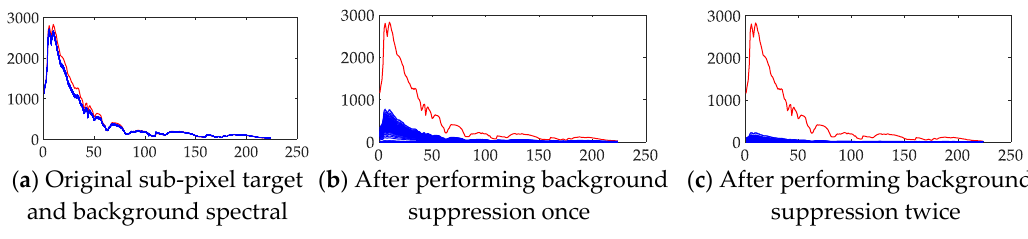
Figure 7. Sub-pixel anomaly target compared with background spectra. ( a ) Original sub-pixel target and background spectra; ( b ) these spectra after applying the background restrain process one time, and ( c ) these spectra after performing background suppression twice. Vertical axis stands for value of spectra vector, wheres horizontal axis stands for band numbers.